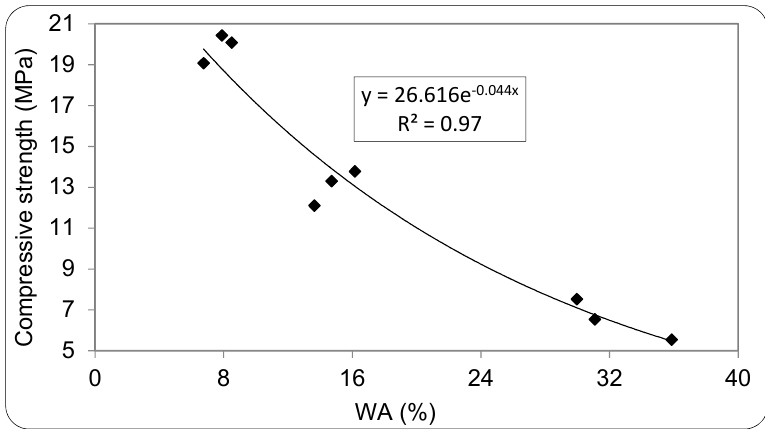
Figure 13. Relationship between strength and WA.